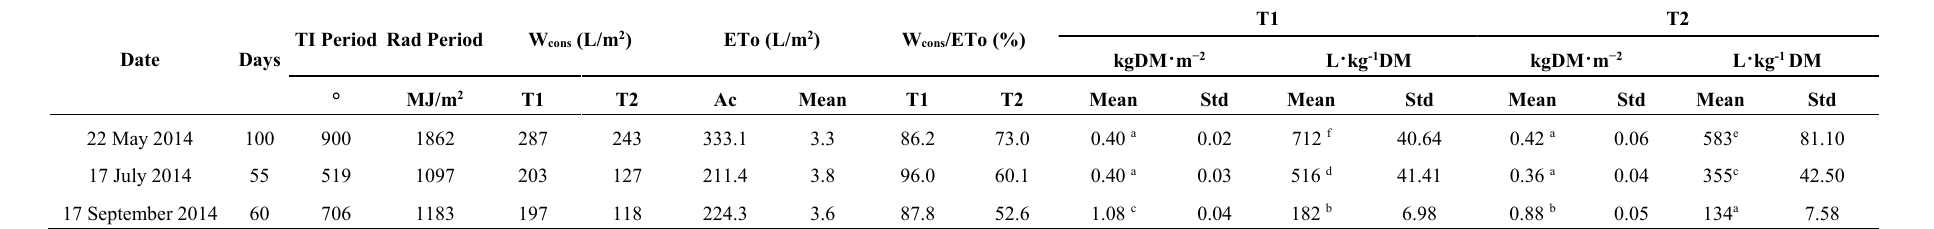
Table 3. Period of study (days); thermal integral (TI); radiation (rad, MJ·m −2 ), water consumption, W cons , (L·m −2 ); accumulated (Ac) and mean evapotranspiration (ETo, L·m −2 ); water consumption/ETo (%); production (kg·m −2 DM) and water consumption per kg of dry matter (Water consumption coefficient, L·kg −1 DM) produced for the different harvest periods and treatments, for T1 and T2 expressed by mean and standard